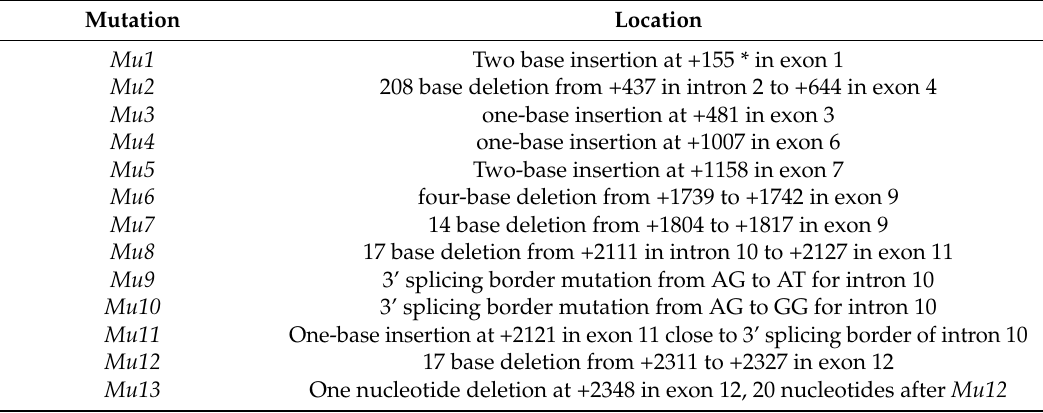
Table 1. Frame-shift mutations identified in AtTGG6 alleles in Arabidopsis thaliana